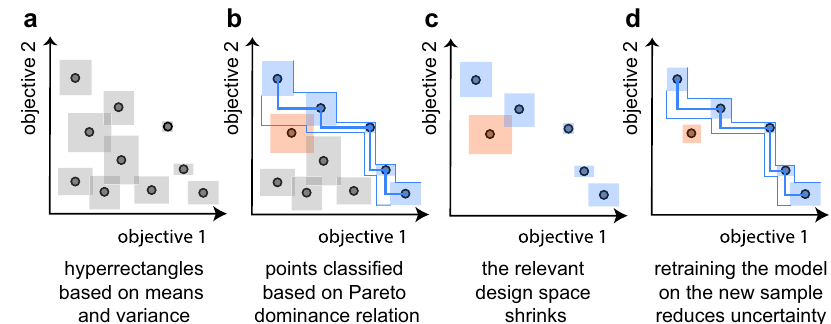
Fig. 4 Illustration of the working principle of the ϵ -PAL algorithm. a For each point, we construct hyperrectangles around the mean μ (coming from either from the model predictions or the measurement) with widths proportional to the uncertainty σ (which is the SD of the posterior of the points we did not sample yet and the estimated uncertainty of the measurement for the sampled points; the exact width of the uncertainty hyperrectangles is also a function of the hyperparameters and the iteration). b Using the ϵ -Pareto dominance relation, we can identify which points can be discarded with con fi dence and which are with high-probability Pareto optimal. c After this classi fi cation, the design space that is relevant for search is smaller and we can sample the largest hyperrectangle to reduce uncertainty (the orange one in this case). d After performing the simulations for the sampled material (orange), the model uncertainties decrease, notably in the neighborhood region of the